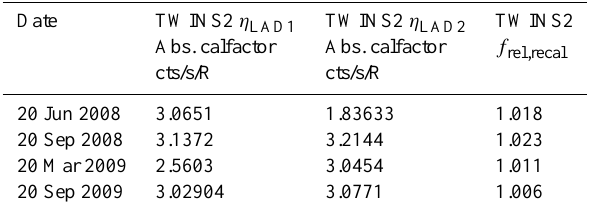
Table 2. TWINS1-LAD (absolute and relative f rel,recal ) effectivity calibration factors, newly calibrated for 2010.